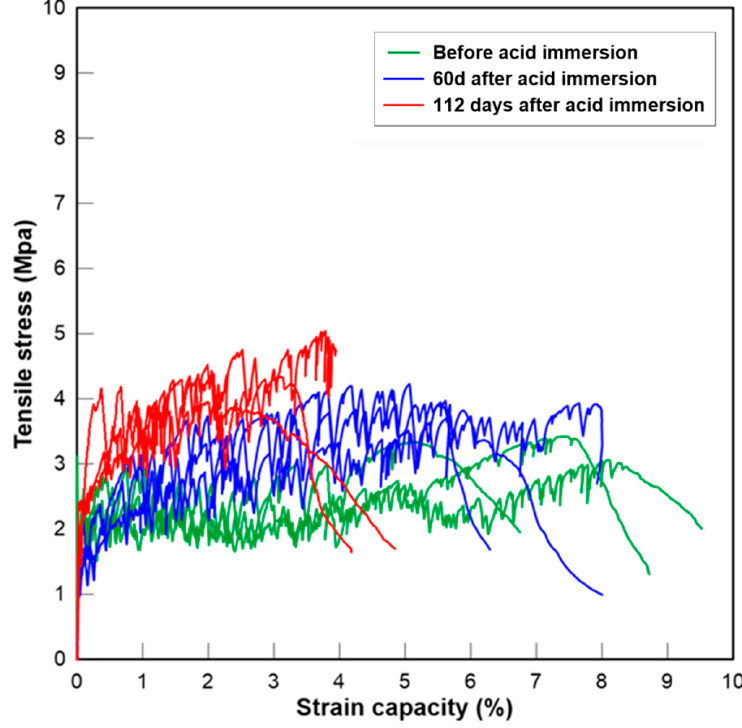
Figure 11. Tensile stress-strain curves of CAC-GGBFS 3.8PE. Materials 2020 , 13 , x FOR PEER REVIEW